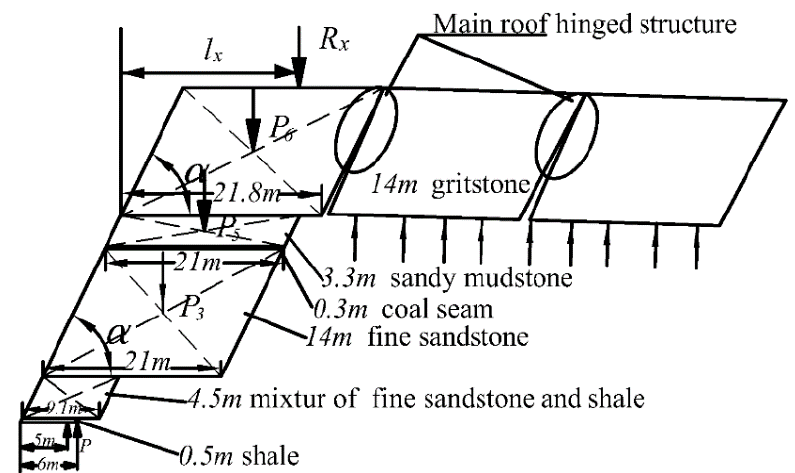
Figure 3. Mechanical model of cantilever of immediate roof.